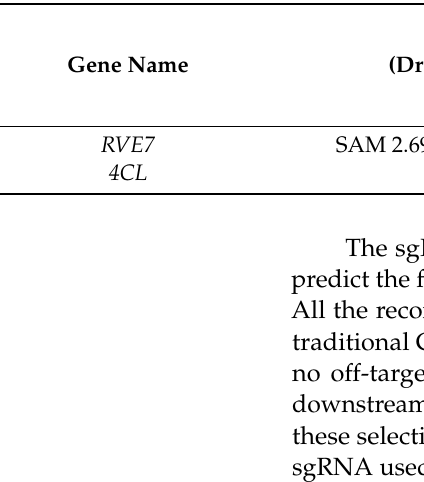
Table 1. The gene expression values of the RVE7 and 4CL in both genotypes. Shoot apical meristem (SAM), flowering bud (FB), fully opened flower (FOF), young pod (YP), partially open flower (POF).